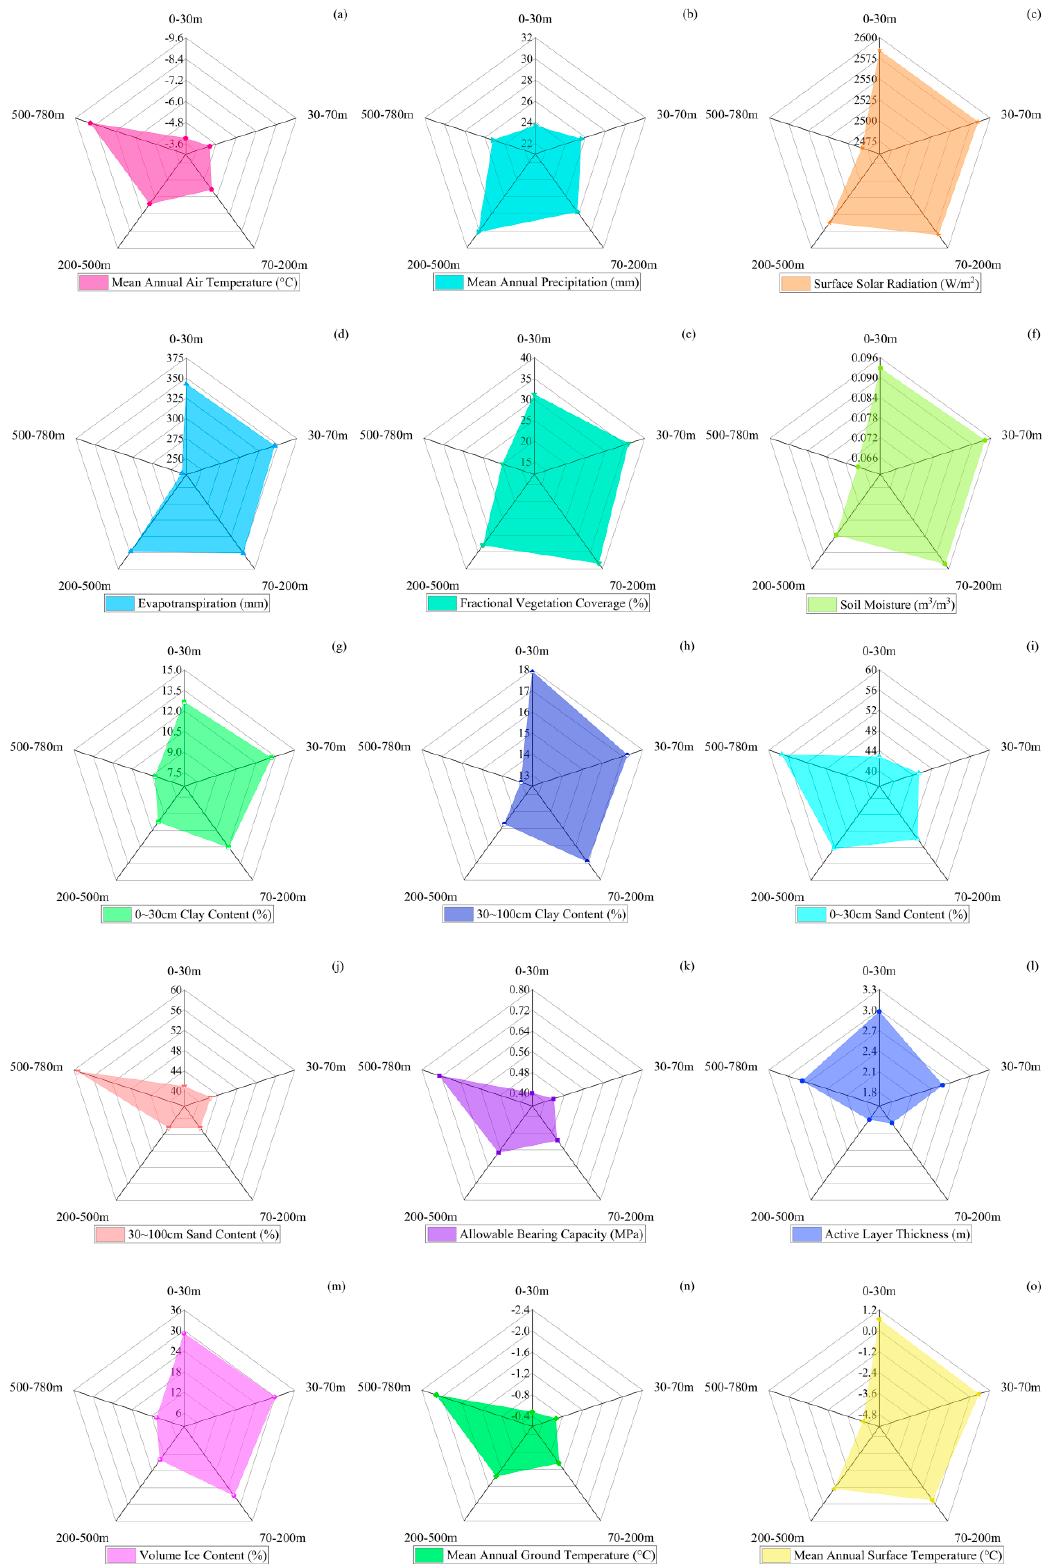
13 of 33 Figure 7. Changes in risk factors considering aspect: ( a ) MAAT; ( b ) MAP; ( c ) SR; ( d ) ET; ( e ) FVC; ( f ) SM; ( g ) CC1; ( h ) CC2; ( i ) SC1; ( j ) SC2; ( k ) ABC; ( l ) ALT; ( m ) VIC; ( n ) MAGT; ( o ) MAST. 4.1.4. Relationship between RDLS and Other Risk Factors According to the aspect classification shown in Table 6, the distribution characteris- tics of the mean values of the risk factors in different RDLS areas were analyzed by using the radar chart, as shown in Figure 8. According to the analysis of the relationship between